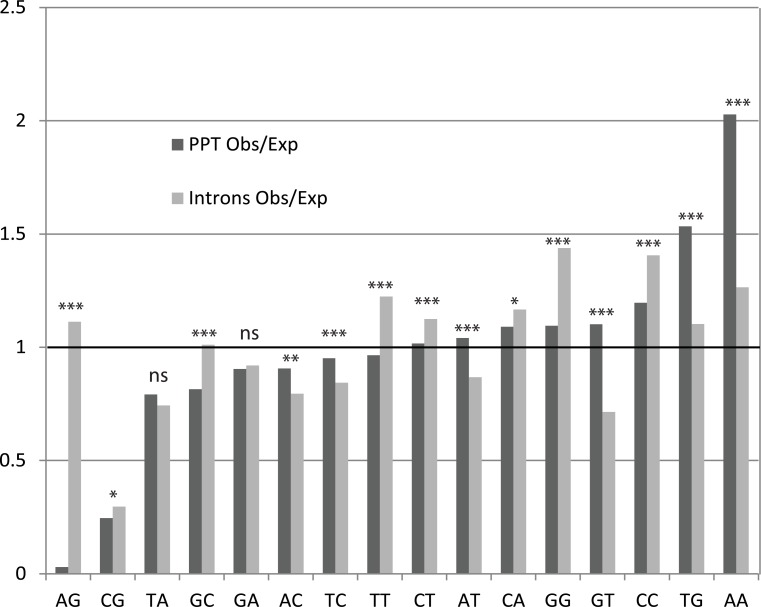
Dinucleotide frequencies within the region of periodic correlations (positions (-12, -7)) of PPT.Observed/expected ratio of dinucleotide frequencies within PPT (positions (-12, -7)) and within adjacent intron. Dinucleotides are ordered by the observed/expected ratio within PPT, from low to high. The expected values were obtained based on mononucleotide content. The significance of the difference between observed/expected ratio within PPTs and within adjacent introns are indicated: * 0.01 < p ≤ 0.05; ** 0.001 < p ≤ 0.01; *** p ≤ 0.001; ns p > 0.05.